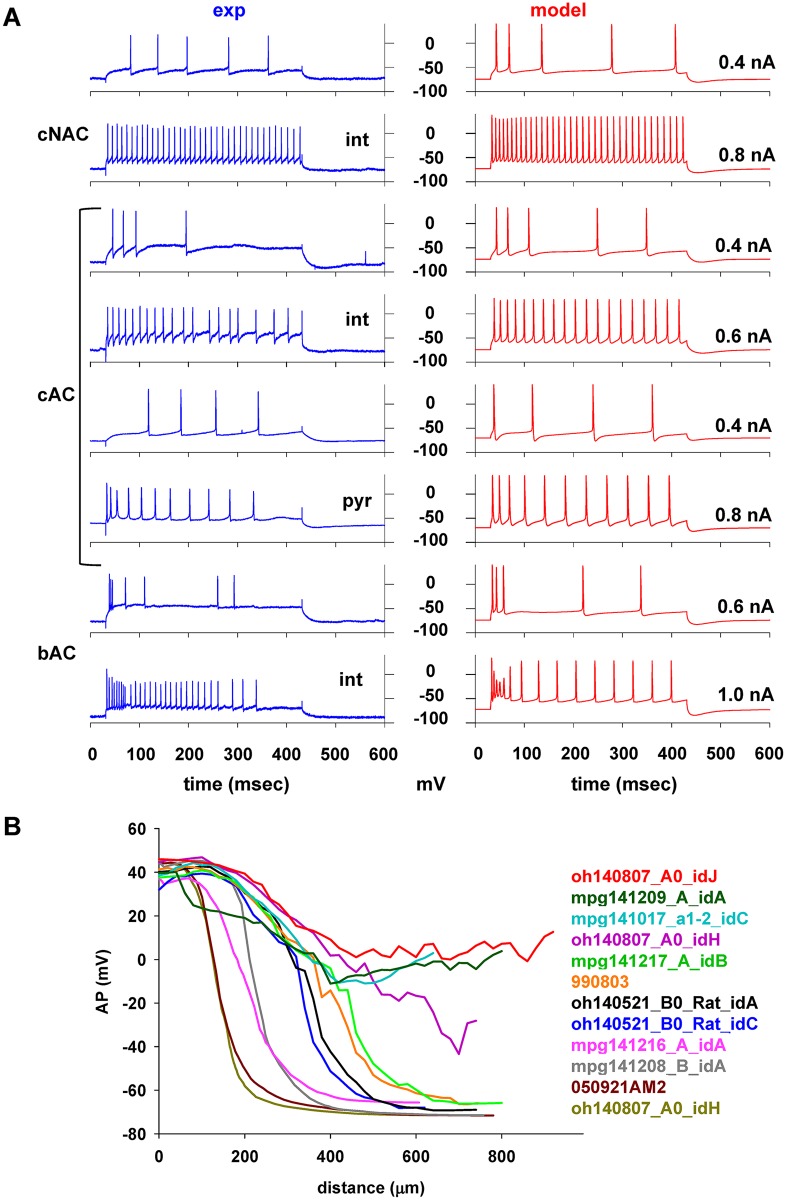
Optimization results.(A) Comparison between typical experimental and model traces for each e-types under different somatic current injection. (B) Peak amplitude of an AP backpropagating in the main apical dendritic trunk of different pyramidal cell models, as a function of the distance from the soma. Each trace refers to a different morphology, as indicated. Abbreviations: cAC, continuous accommodating cells; cAC, bursting accommodating cells; cNAC, continuous non-accommodating cells.